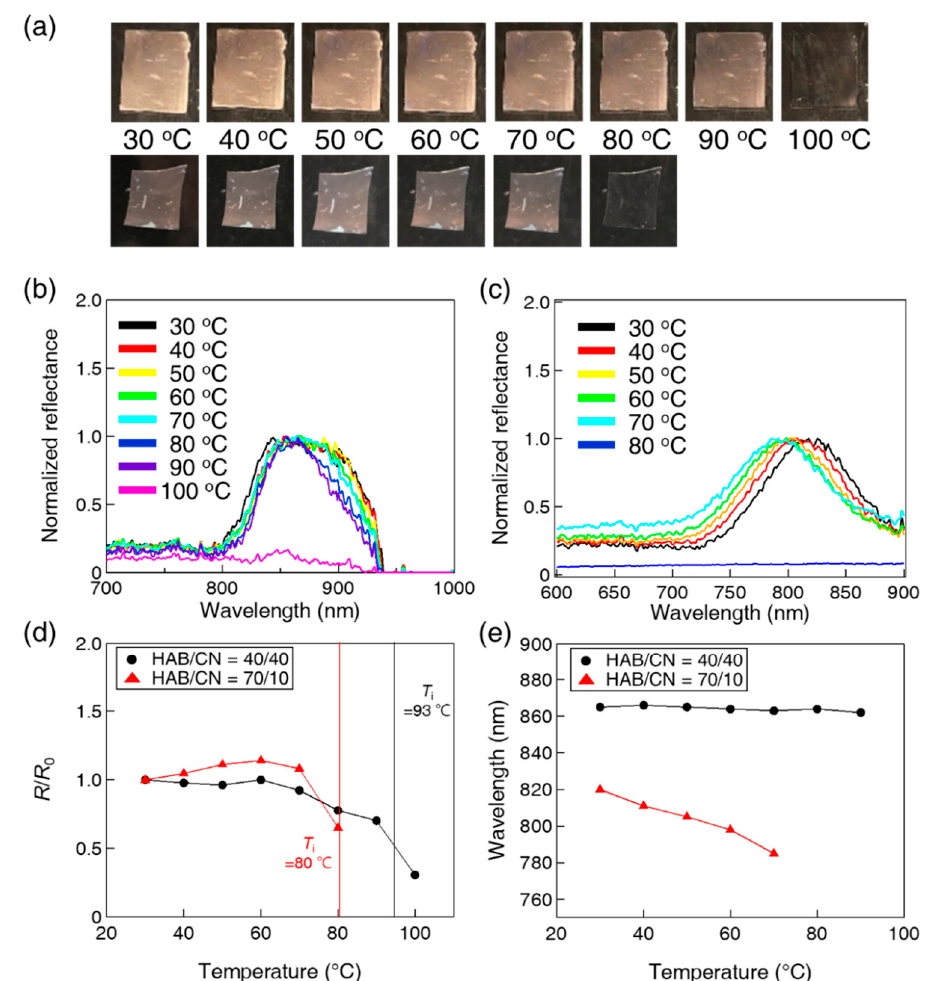
Figure 3. ( a ) Photographs of N* LC (2.0) elastomers with HAB/CN = 40/40 (top) and HAB/CN = 70/10 (bottom) at different temperatures. Reflectance spectra of N* LC (2.0) elastomers with ( b ) HAB/CN = 40/40 and ( c ) HAB/CN = 70/10 at different temperatures. ( d ) Relative reflectance intensity ( R / R 0 ; R , reflectance at a certain temperature; R 0 , initial reflectance at 30 °C) and ( e ) reflectance peak wavelength of N* LC (2.0) elastomers with HAB/CN = 40/40 (black circles and line) and HAB/CN = 70/10 (red triangles and line) as a function of temperature.